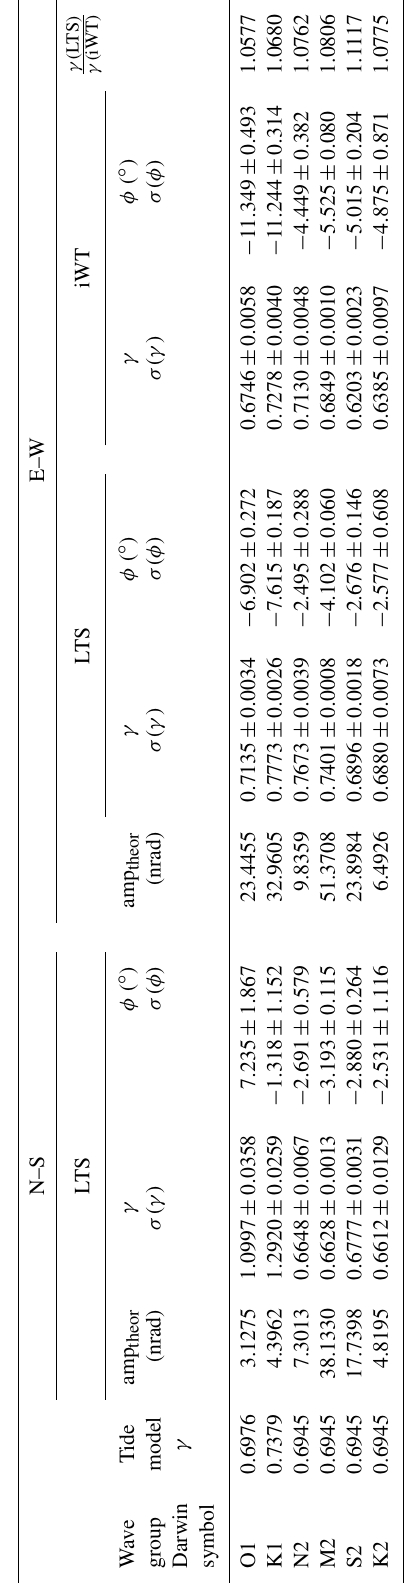
Table 2. Air pressure admittances in the diurnal and semidiurnal frequency band for the tilt sensors derived from tidal